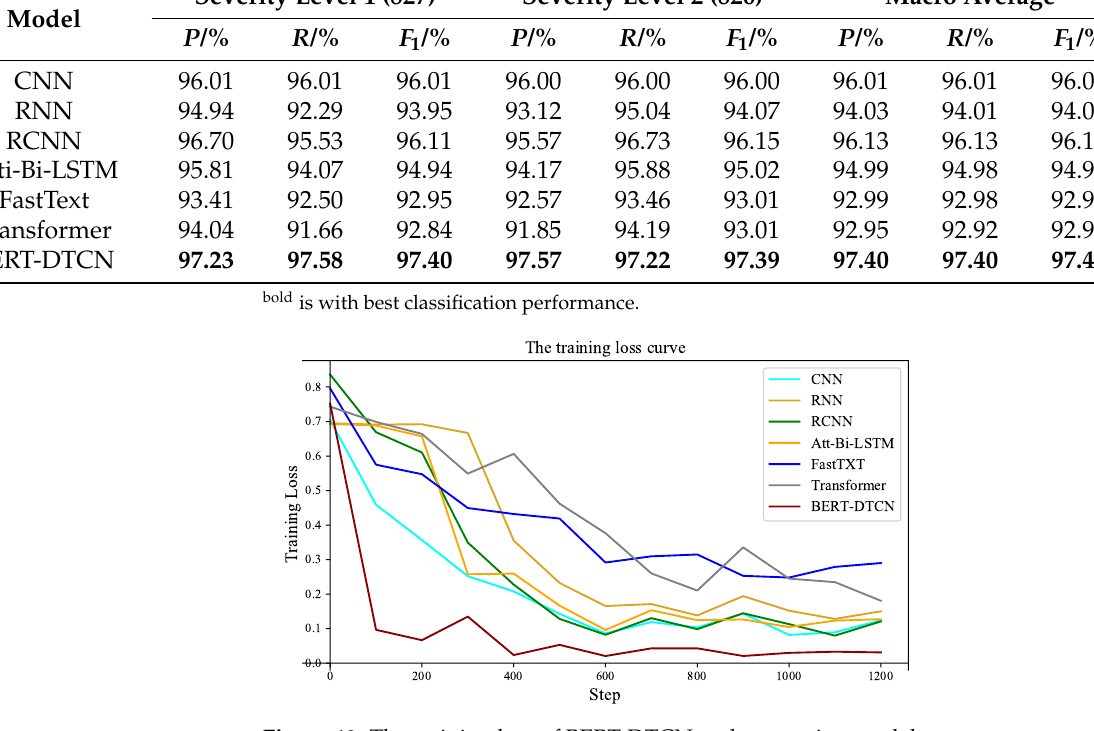
Figure 12. The training loss of BERT-DTCN and competing